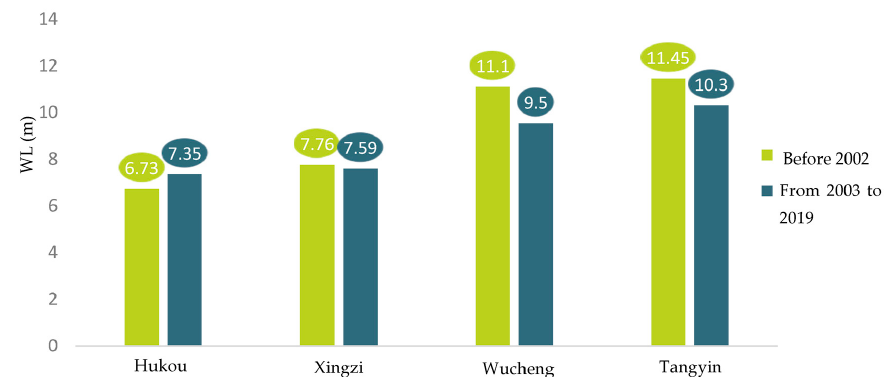
Figure 8. Change of the water level with a 98% guarantee rate of duration at the main hydrometric stations in the lake area in different periods. According to the analysis of all the previous annual water levels with a 98% guaran- tee rate of duration at the Hukou, Xingzi, Wucheng, and Tangyin hydrometric stations, that at the Hukou hydrometric station showed an upward trend, whereas those at the Xingzi, Wucheng, and Tangyin hydrometric stations presented downward trends.